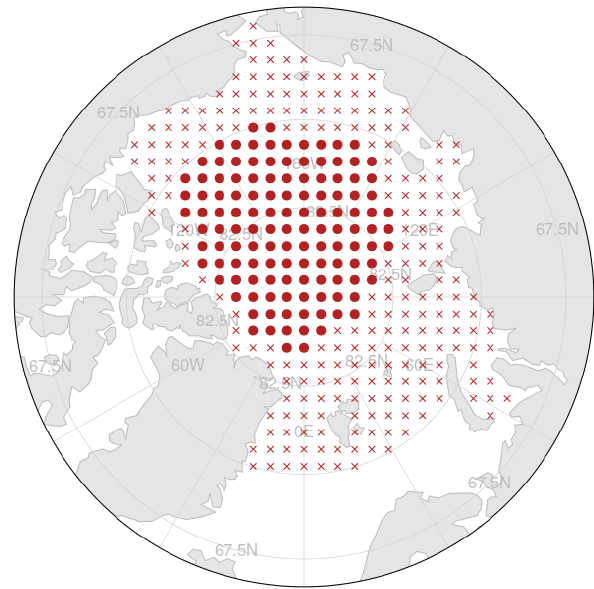
Figure 1. Map of all initial positions for trajectory computation (red crosses and circles). The initial positions with a solid red circle con- stitute the common subset of initial positions for all models after the filtering process outlined in Sect.